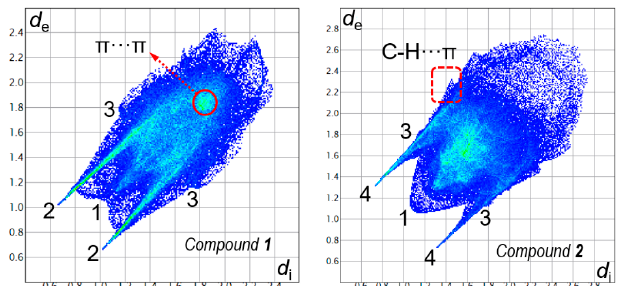
with a contribution of 14.3% to the Hirshfeld surface area. These contacts are visible in the Crystals 2023 , 13 , 203 d norm surface as small red spots labeled 4 and comprise 76% of the total HS area.